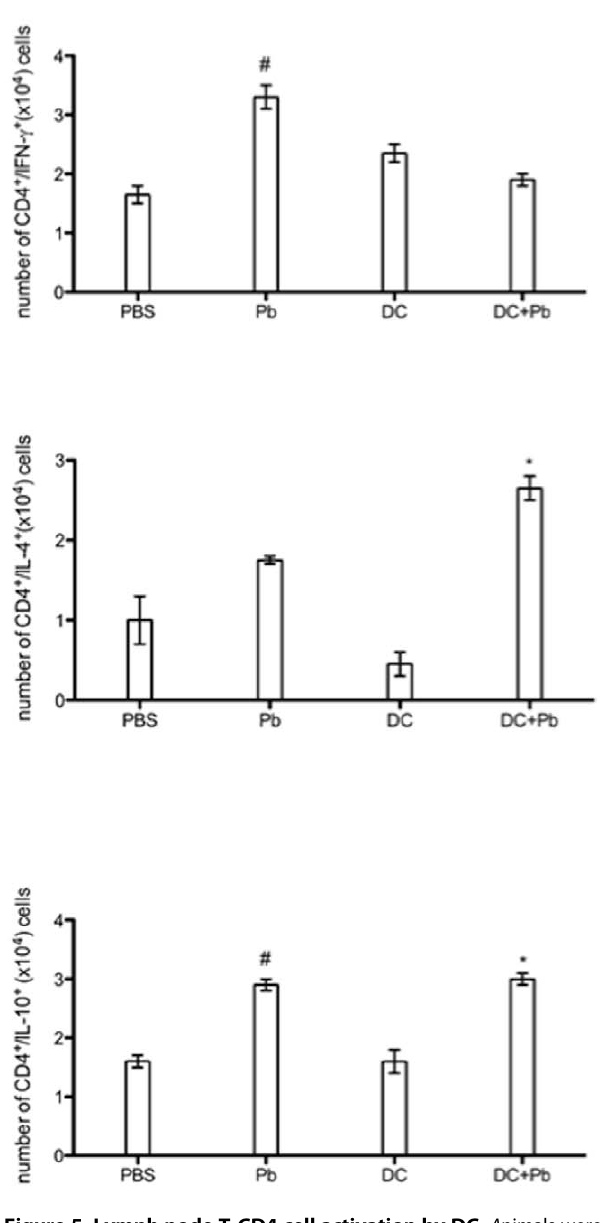
Figure 5. Lymph node T-CD4 cell activation by DC. A nimals were injected with Pb or Pb -pulsed BM-DC, and intracellular cytokines from T cells present in the lymph nodes were investigated. The data represent the mean 6 SEM of the results from 3 independent experiments. Error bars represent the standard errors of the means (SEM). *p , 0.05 when compared between DC vs. DC + Pb infection or # p , 0.05 when compared between PBS vs. Pb infection.